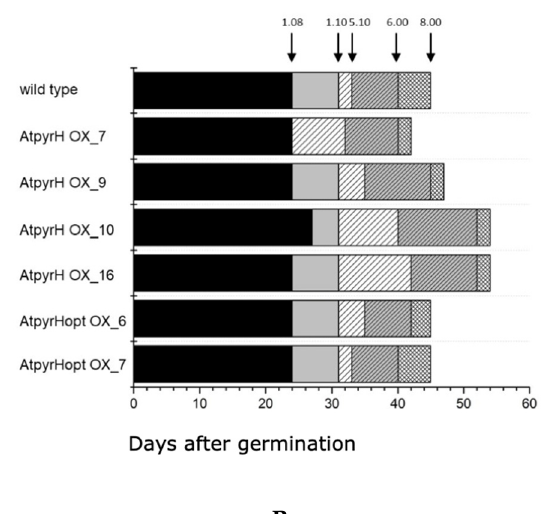
Figure 5. A : Numbers of rosette leaves (black histograms) and diameter of the rosettes (grey histograms)